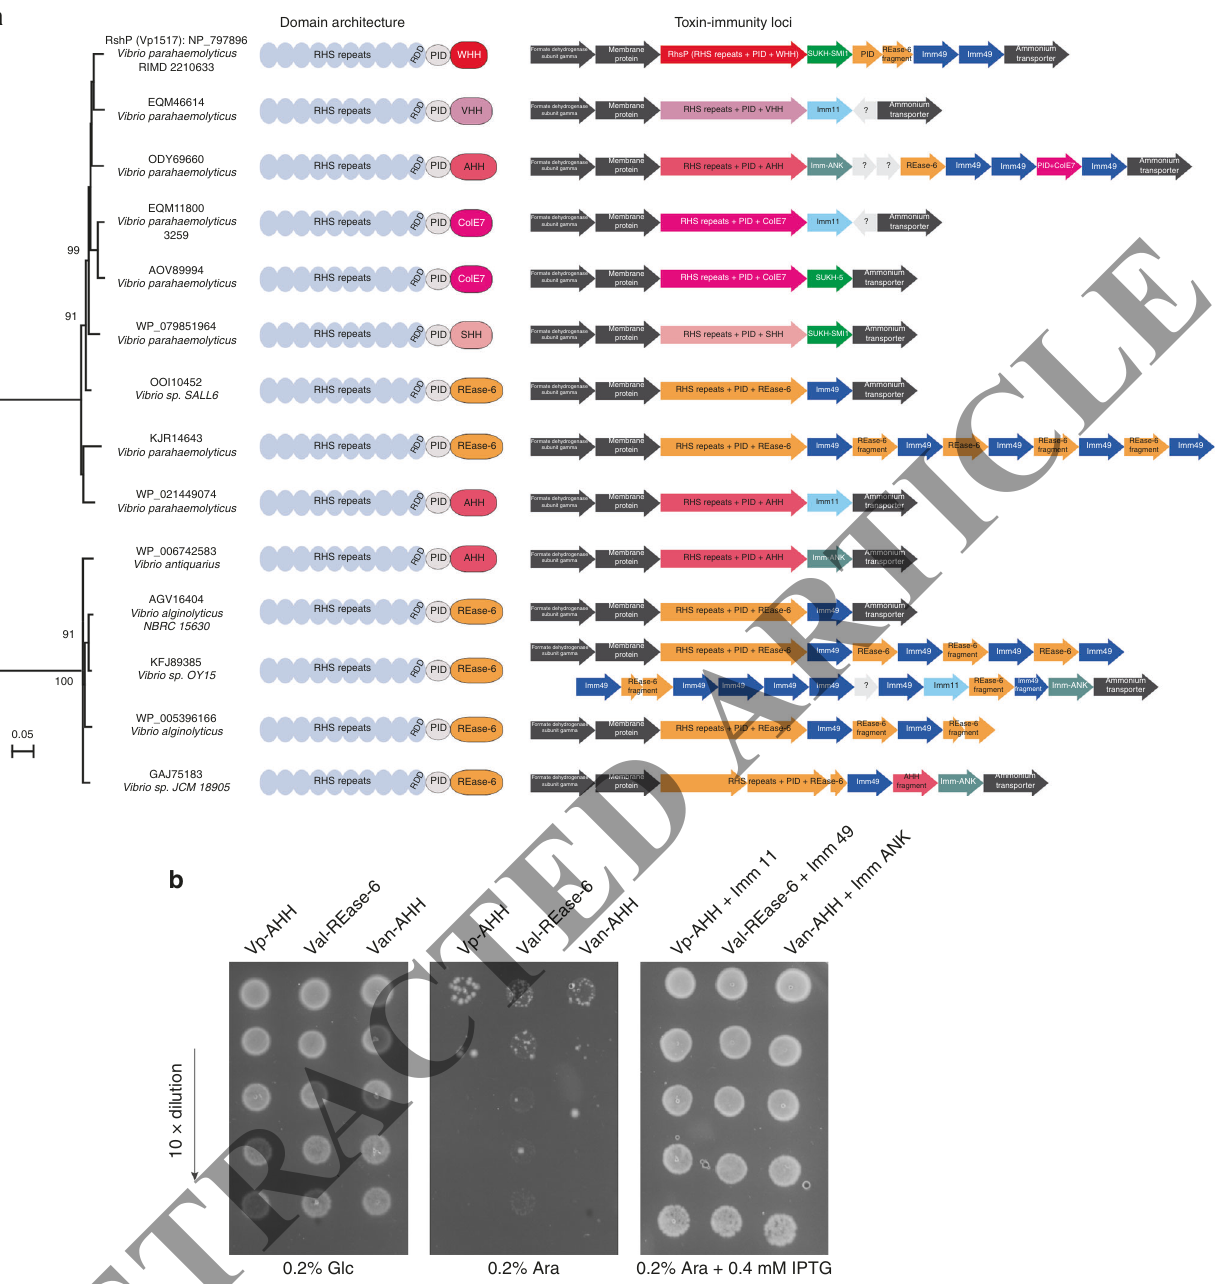
Fig. 6 Organizational and functional diversity of Pro-effectors in Vibrio species. a Domain architecture of pro-effectors from different Vibrios and their corresponding genomic organization. A phylogram of evolutionary relationship between RhsP homologs were shown. b Several representative pro-effectors are functional toxins. The toxin domains of putative pro-effectors from V. parahaemolyticus (Vp-AHH), V. alginolyticus (Val-REase-6), V. antiquaries (Van- AHH) (bacterial names were in boldface in ( a )) were expressed from pBAD24 in E. coli DH5 ⍺ to test their toxicities. The putative immunity proteins encoded immediately following the individual pro-effector (Imm11, Imm49, and ImmANK, respectively) were expressed from pCX340 to test the neutralization effect on the above toxins. The expression of the toxin domain of pro-effector was repressed by glucose and induced with arabinose. The immunity proteins were induced by